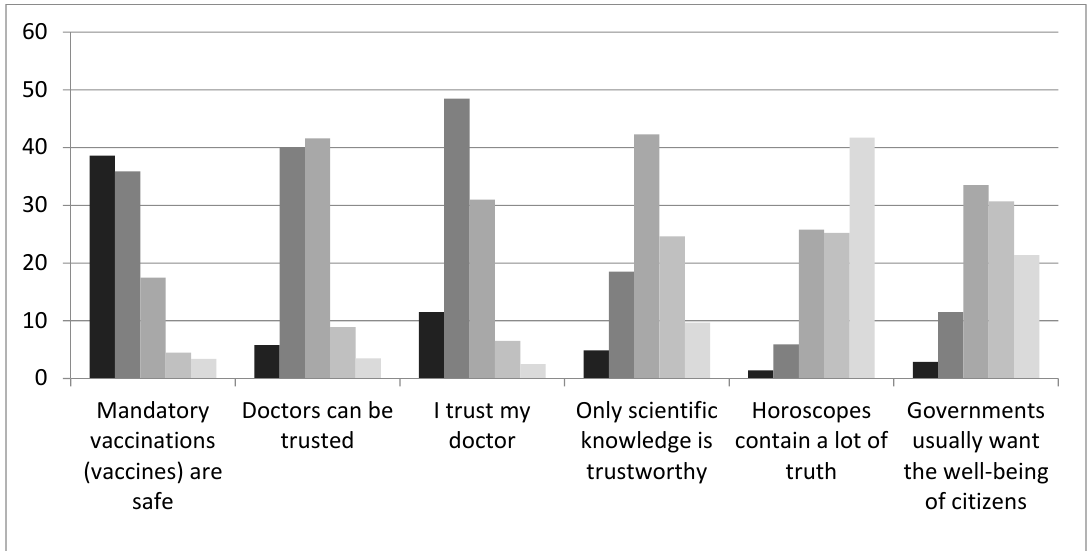
Figure 1. Participants’ responses to the question ‘How much do you agree or disagree with the following statement?’, Poland, 2019 ( n = 1079). Table 3. Correlations between vaccine confidence and trust in doctors and medicine, scientific knowledge and the government ( n = 1079).